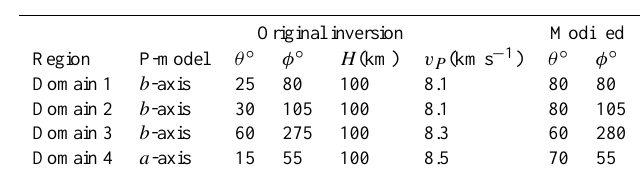
Table 1. Anisotropic models retrieved by the P-sphere inversion, along with modifications of inclination angle to fit the shear-wave